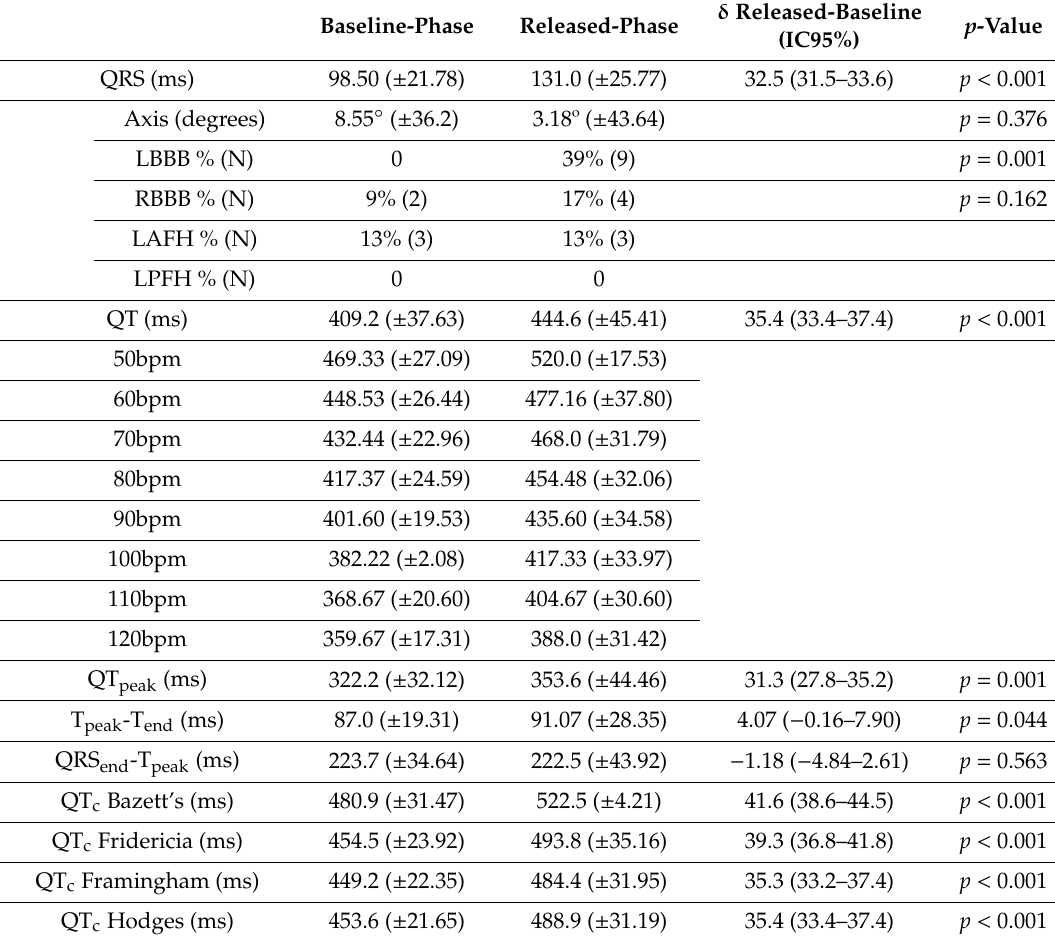
Table 2. Comparative analysis of ECG morphology and measurements between